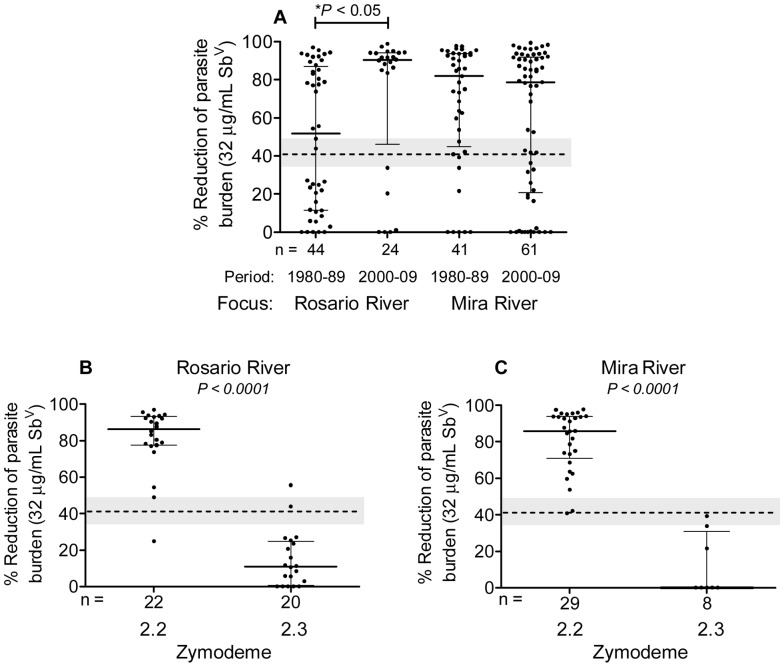
Susceptibility of L. V. panamensis strains to meglumine antimoniate in endemic foci of Tumaco and association of drug susceptibility with zymodeme.Distribution and median susceptibility of clinical strains from the Rosario River and Mira River foci during the decades 1980–1989 and 2000–2009. K-W, P<0.0001 and Dunn procedure (A). Comparison of susceptibility of strains pertaining to zymodeme 2.3 and zymodeme 2.2 isolated during 1980–1989 from the Rosario River and Mira River foci to SbV (B and C). Qualitative classification of susceptibility is defined by the cutoff thresholds (dotted horizontal line) and indeterminate ranges are illustrated by gray shading. Mann-Whitney, P<0.0001.